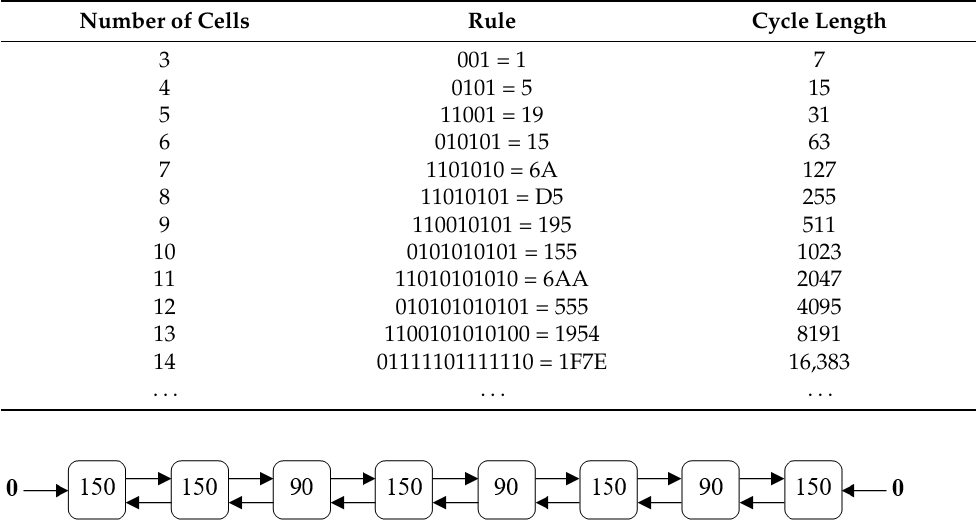
Table 2. Combination of evolution rules.